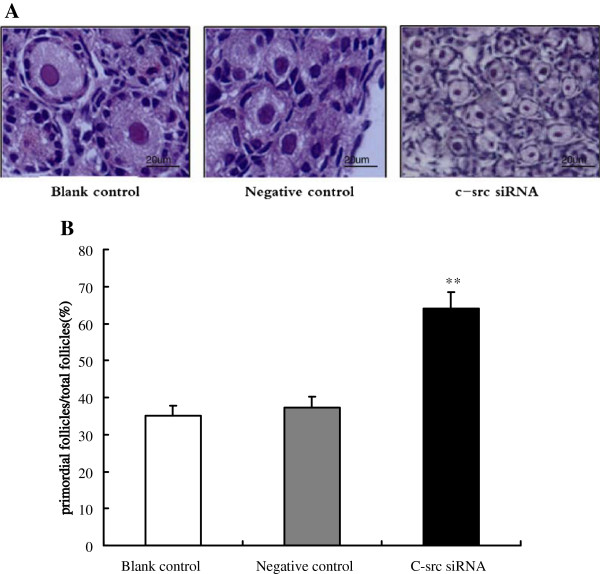
Effect ofc-srcsiRNA on the activation of primordial follicle growth.A, Ovaries were cultured for 8 days with the indicated treatments: blank control, negative control, 100 μmol/L siRNA targeting c-src. Ovarian sections were stained with hematoxylin and eosin to show the follicles at different developmental stages. Scale bar: 20 μm. HE staining X400 B, The number of follicles was counted in serial cross-sections. The percentage of the number of each category over the total number was plotted. The data are presented as the means ± SEM. Bars with different superscripts are statistically different (P<0.01). Blank control corresponds to the group with c-src-non-targeting oligonucleotides, the negative control corresponds to the group with blank vector (lentivirus without siRNA), and c-src siRNA corresponds to the group with lentivirus packaging c-src siRNA. The data are presented as the means ± SEM (n = 3). **P<0.01 compared with negative control group.